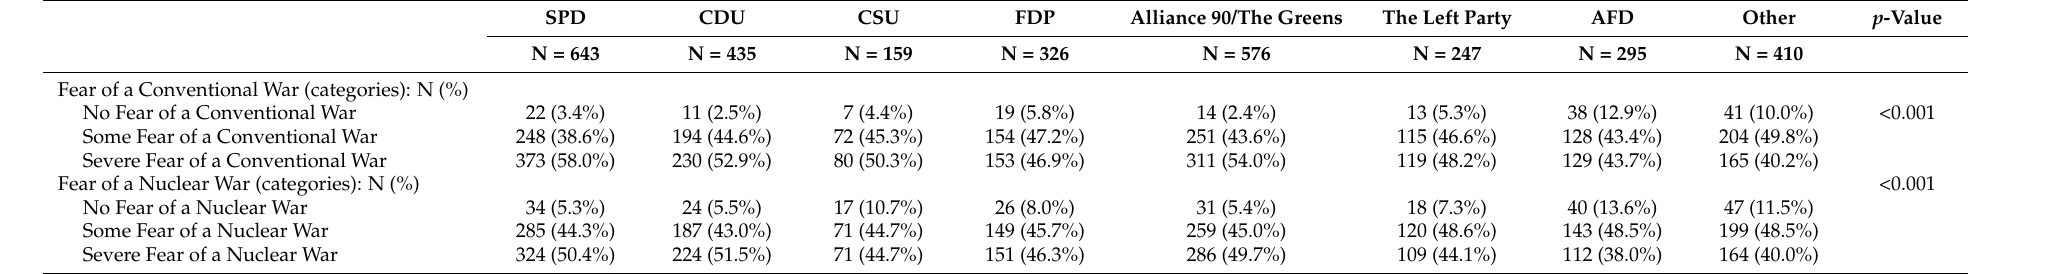
Table 2. Prevalence of fear of conventional war and fear of nuclear war (both trichotomized) stratified by political party affinity. SPD CDU CSU FDP Alliance 90/The Greens The Left Party AFD Other p -Value N = 643 N = 435 N = 159 N = 326 N = 576 N = 247 N = 295 N = 410 Fear of a Conventional War (categories): N (%) No Fear of a Conventional